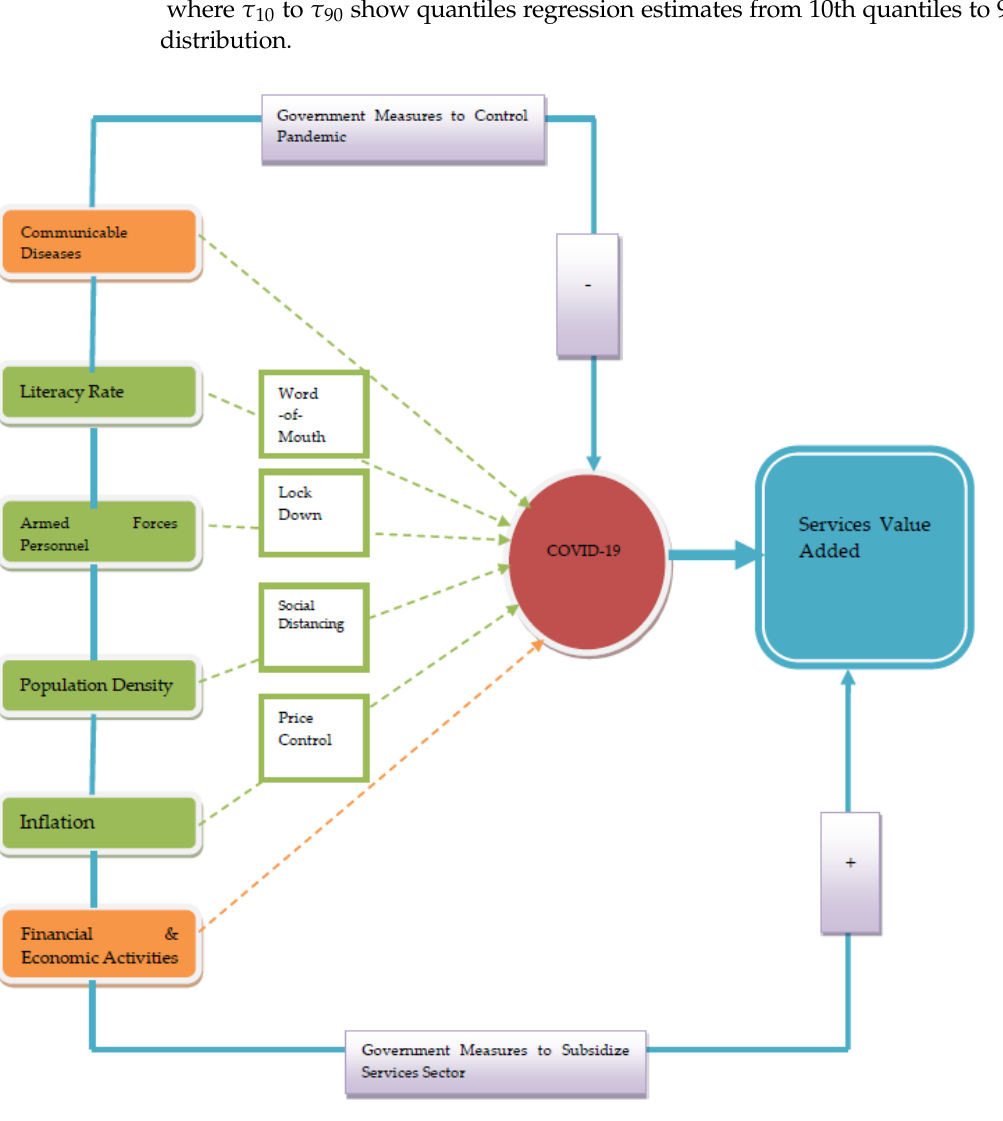
Figure 1. Research Framework of the Study. Source: Author’s extract.